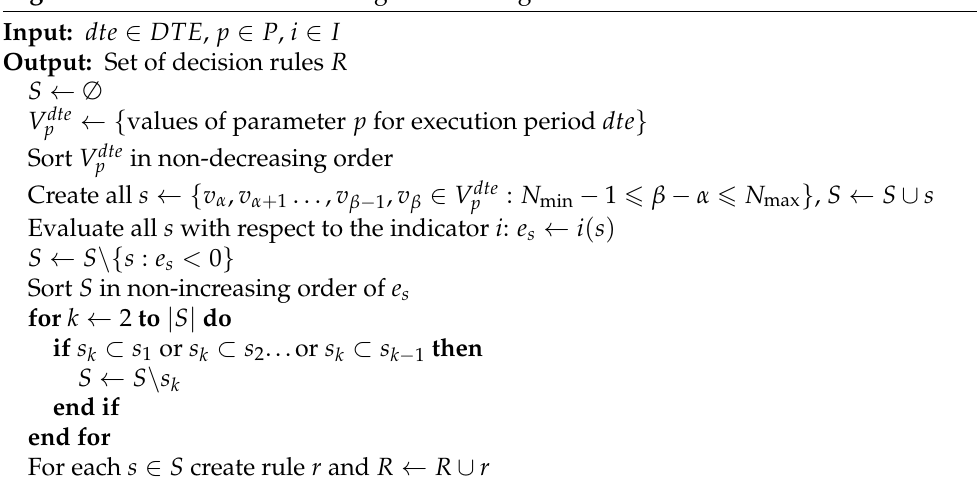
Algorithm 1 Pseudocode of rules generation